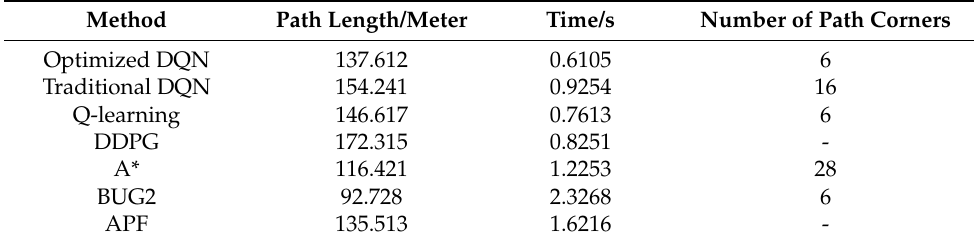
Table 3. The comparison of experimental